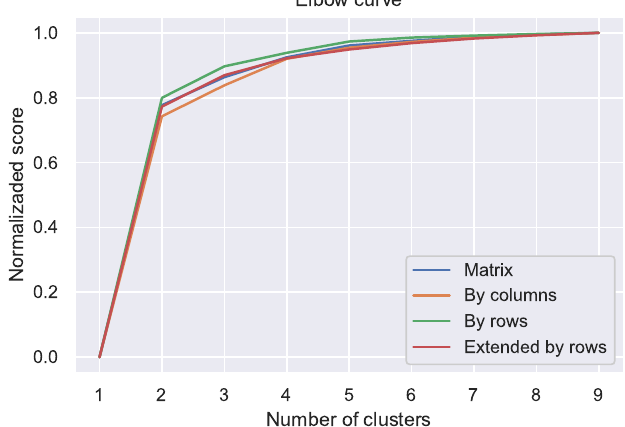
Figure 6. Elbow curves for different